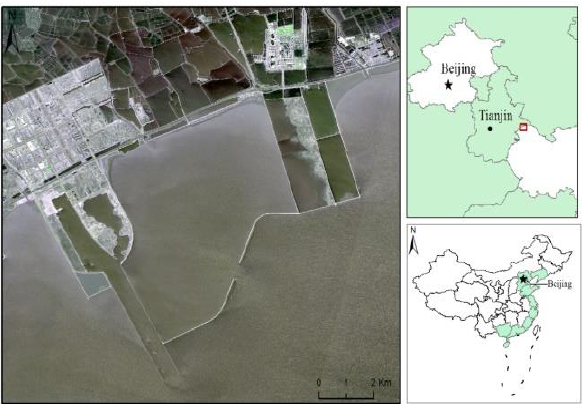
Figure 1. The location and the high resolution remote sensing image of the study